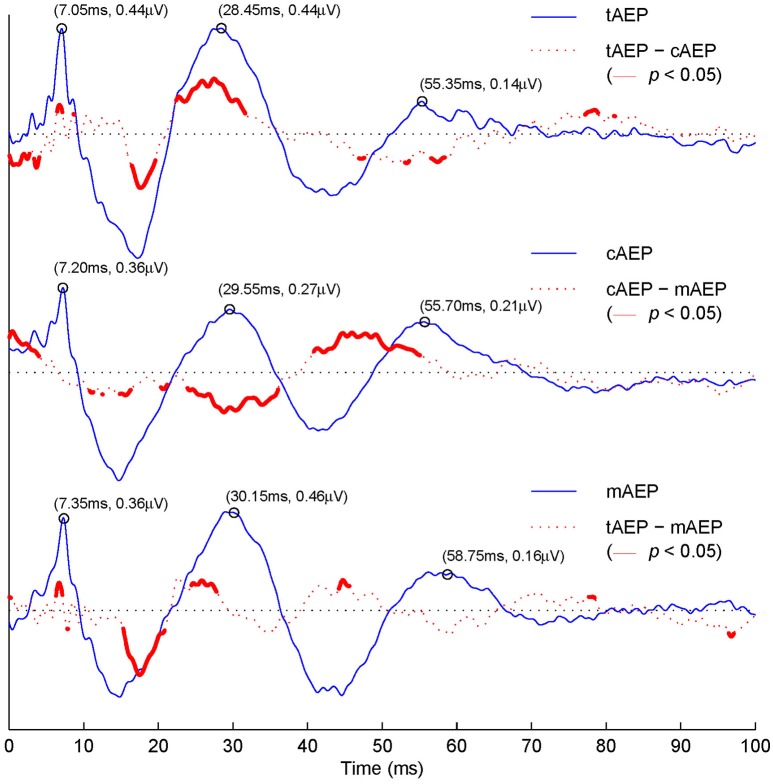
Grand averaged tAEP, cAEP, mAEP, and corresponding paired differences. The 1st row: averaged tAEP (blue solid curve); tAEP–cAEP (red dashed curve), with areas of statistical significant difference (t-test, p < 0.05) in red bold curves. The 2nd row: cAEP and cAEP–mAEP. The 3rd row: mAEP and tAEP–mAEP.